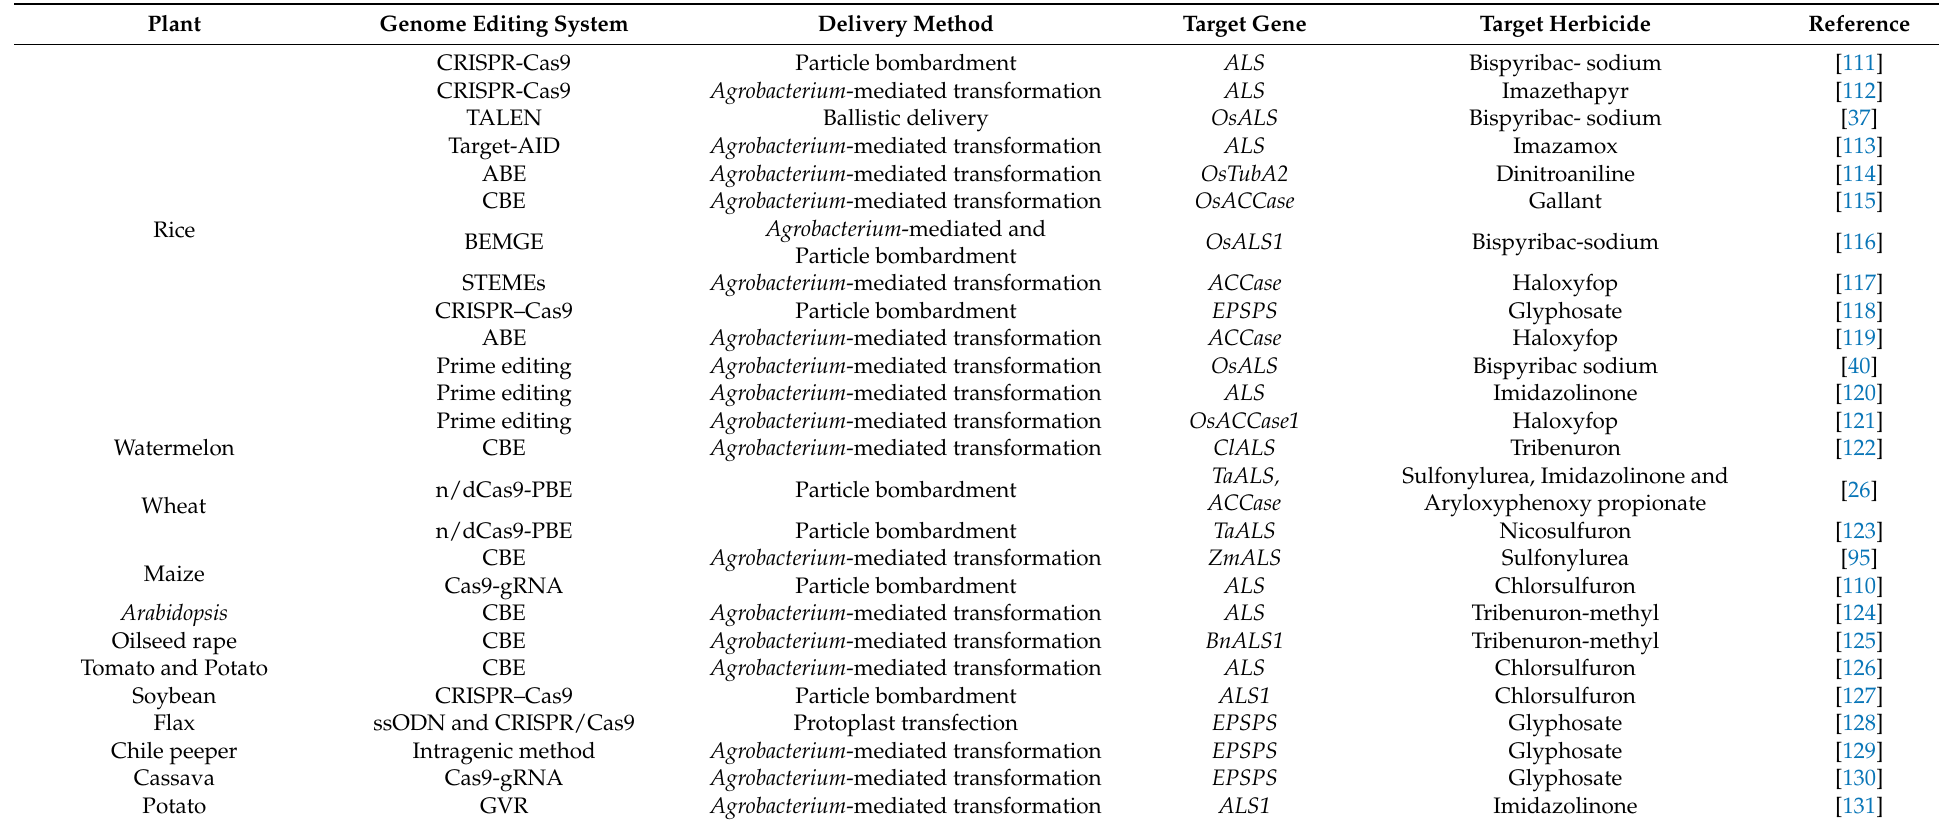
Table 1. Herbicide resistant plants developed through genome